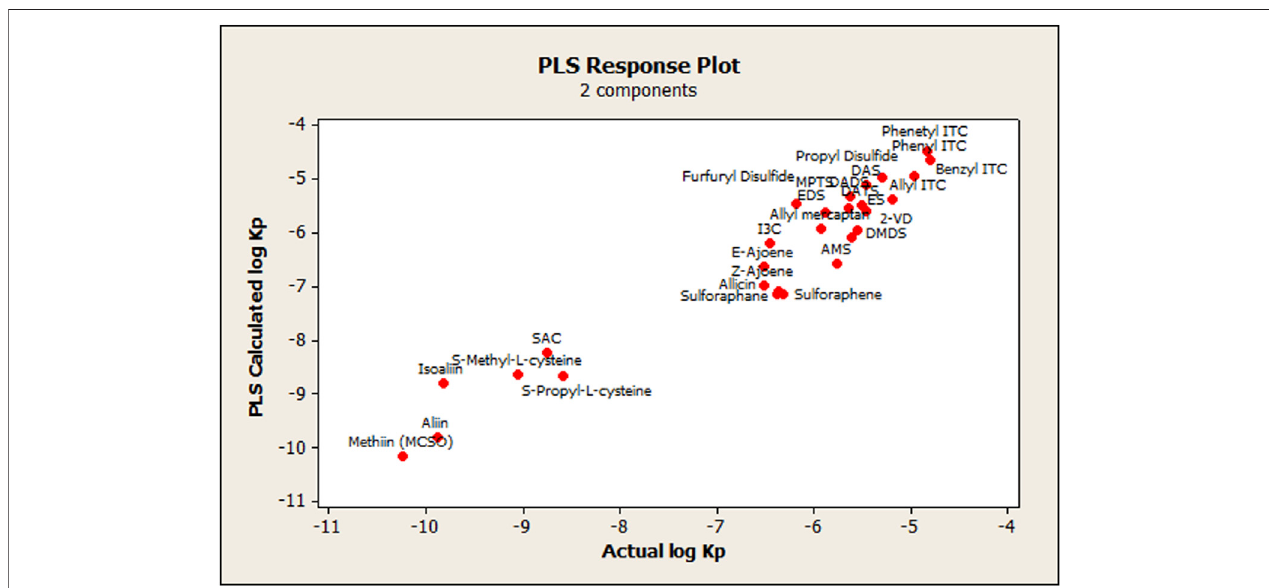
FIGURE 6 | Relationship between actual and calculated log K P skin permeability values using the PLS approach.